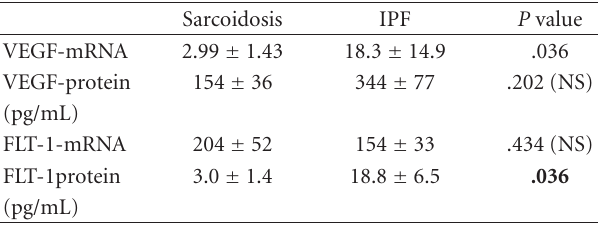
Table 3: mRNA and protein expression of angiogenetic parameters in IPF and Sarcoidosis. Values are expressed as mean ±